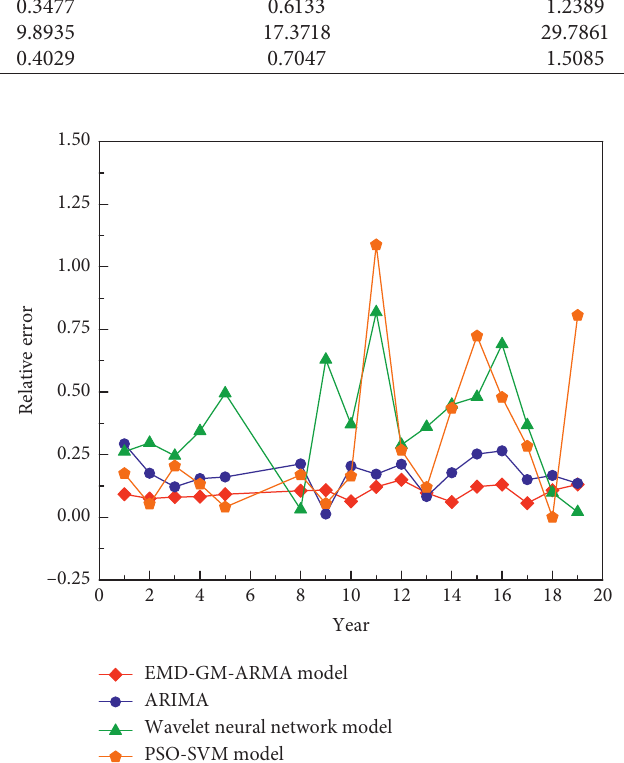
Figure 14: Relative error comparison chart of each model.